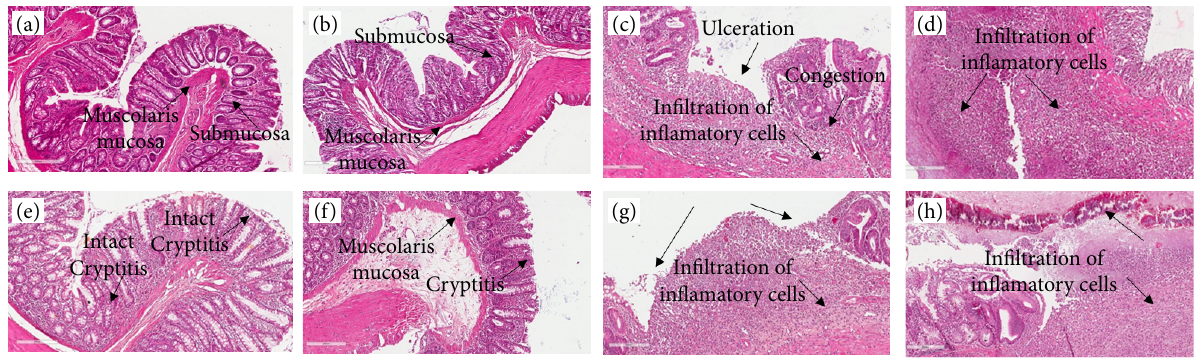
Figure 1 characterizes the histopathological features of colonic mucosa of rats subjected to acetic acid enema and respective treatments.